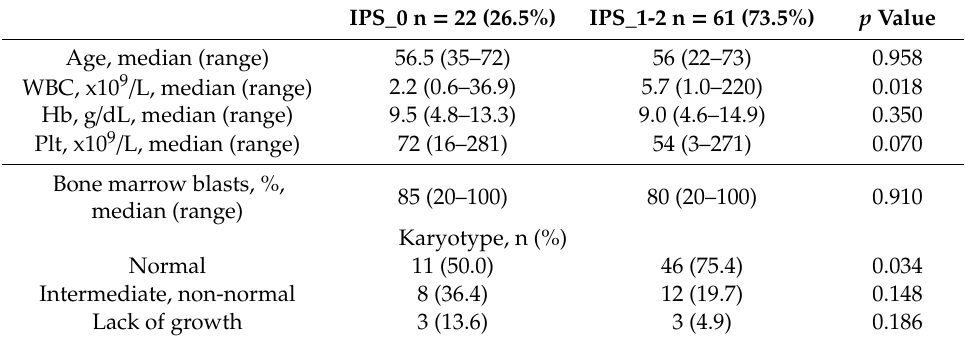
Figure 4. Effect of IPS on EFS in triple-negative AML. Forest plot depicting the effect of IPS-related group (IPS_0 versus IPS_1-2) on EFS in triple-negative AML according to main patient, disease characteristics and induction intensity. HR, hazard ratio; 95% CI, confidence interval; SDAC: standard-dose cytarabine; HDAC: high-dose cytarabine. Upper 95% CI HR values were rounded to 10 for sake of graphical resolution.